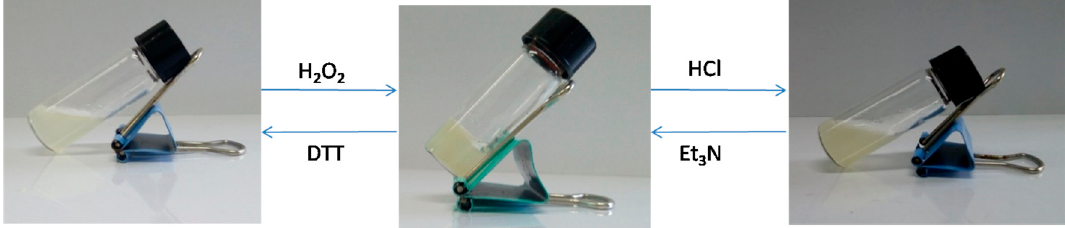
Figure 6. Sol-gel transitions of PEG-DTP/ADA hydrogels in response to pH or redox triggers.